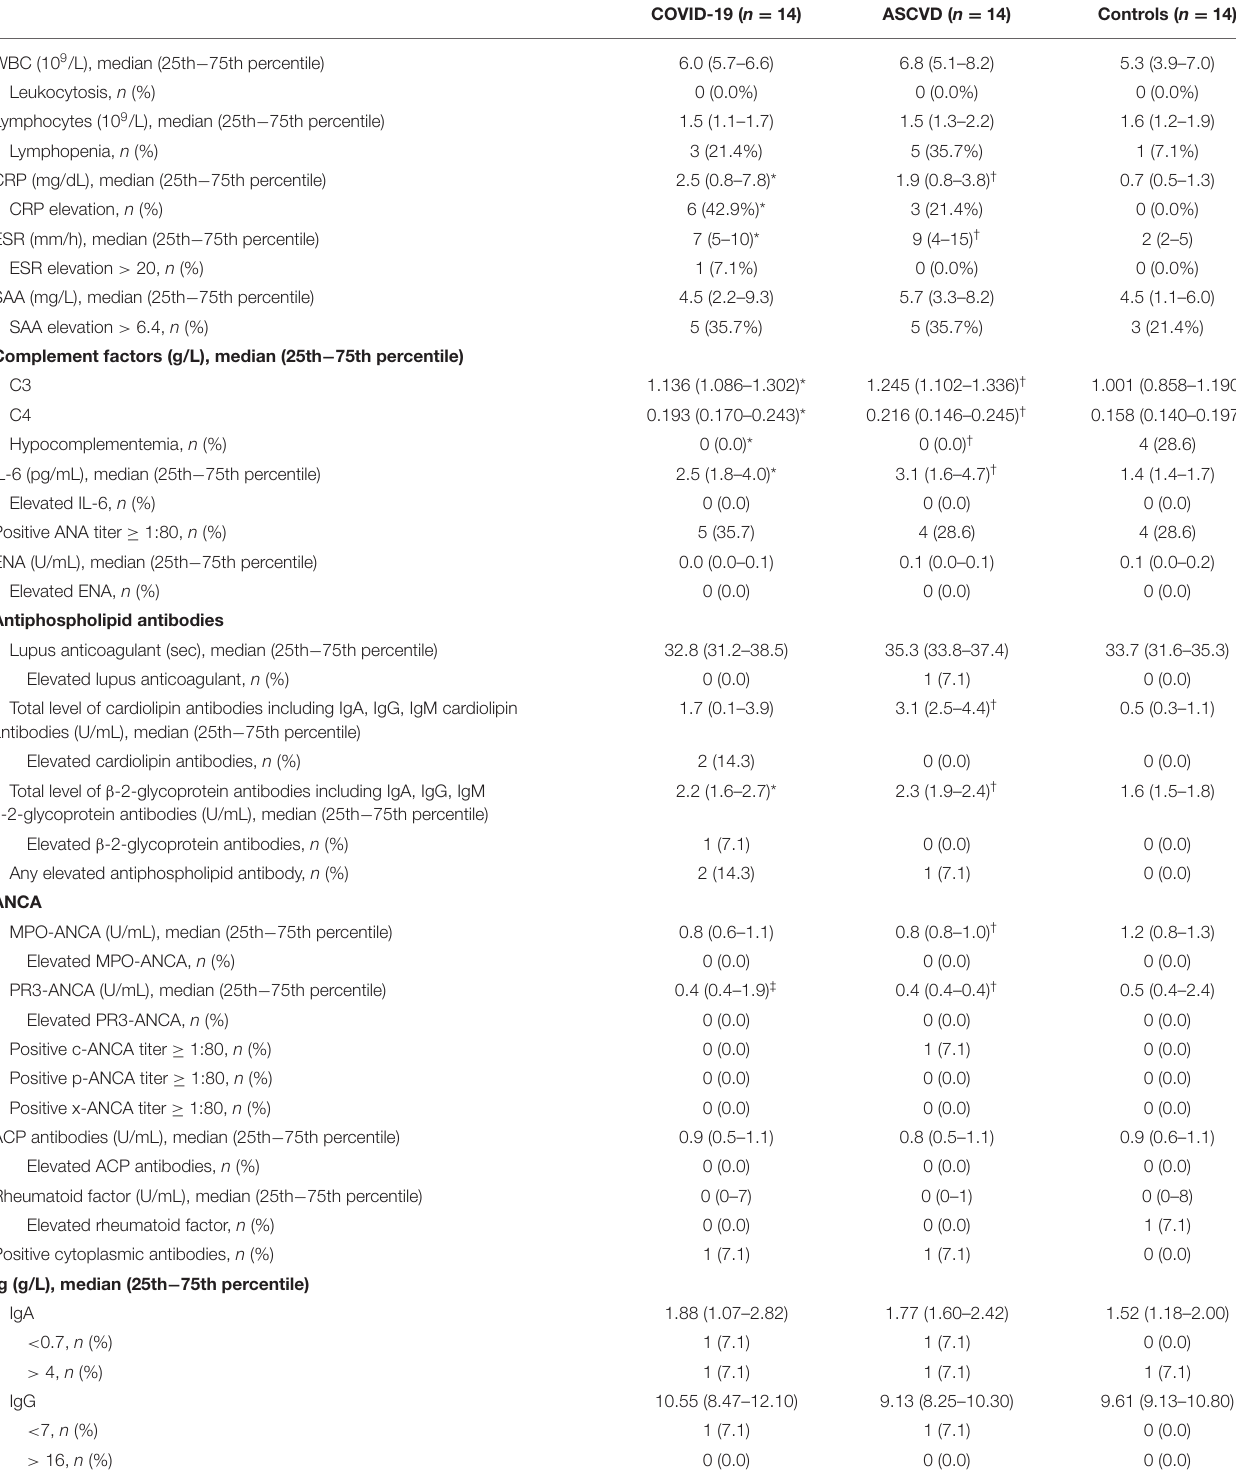
TABLE 4 | Immune-inflammatory